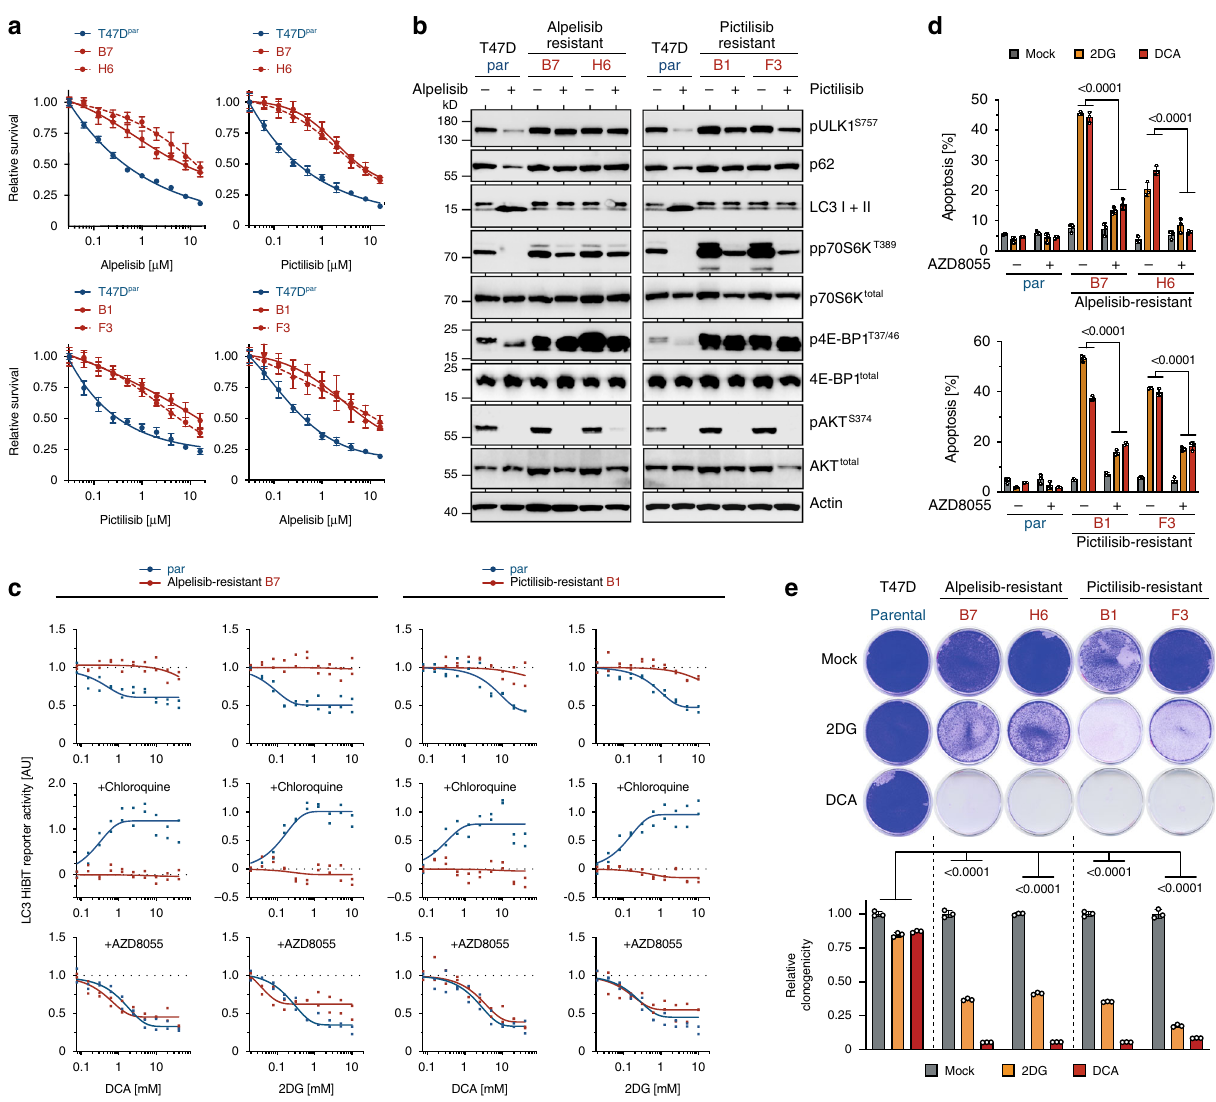
Fig. 6 Metabolic vulnerability of tumor cells resistant to molecular targeted drugs. T47D breast cancer cells were treated with increasing doses of alpelisib or pictilisib to obtain alpelisib-resistant (B7, H6) and pictilisib-resistant (B1, F3) subclones. a Cell viability of indicated T47D cells after 3 day treatment with alpelisib and pictilisib. Shown are mean ± SD, n = 3. b Western blot following treatment with alpelisib or pictilisib for 2 hours. c Autophagic fl ux assay. Parental and alpelisib/pictilisib-resistant LC3-HiBiT expressing T47D cells were pre-treated as indicated with chloroquine and AZD8055 for 48 hours and then with increasing doses 2DG/DCA for 6 hours. Shown is LC3-HiBiT reporter activity measured as luminescence normalized to untreated of n = 2 replicates. d Flow cytometry analysis for apoptosis (sub-G1). Shown are mean ± SD, n = 3, FDR q values. e Clonogenic growth of parental and alpelisib/pictilisib-resistant T47D cells treated with 2DG/DCA. Shown are representative images and quanti fi cation as mean ± SD, n = 3, two-way ANOVA with Dunnett ’ s multiple comparisons